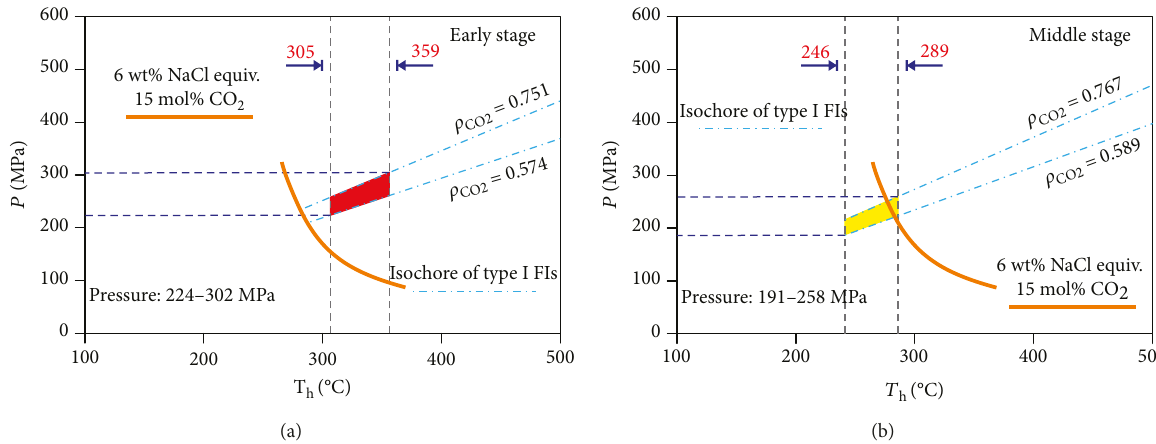
Figure 15: Representative isochores for minimum and maximum CO fl uids containing 6 eq. wt% NaCl and 15 mol% CO H O – NaCl – CO 2 2 pressure-temperature diagram of the early stage; (b) the estimated trapping pressure-temperature diagram of the middle stage. Isochores of the type I FIs are calculated using the FLINCOR